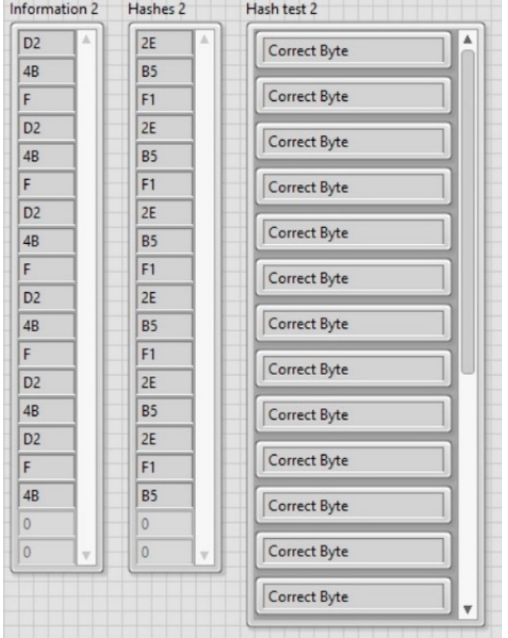
Figure 16. Received information bytes with its corresponding HASH bytes, and HASH validation.